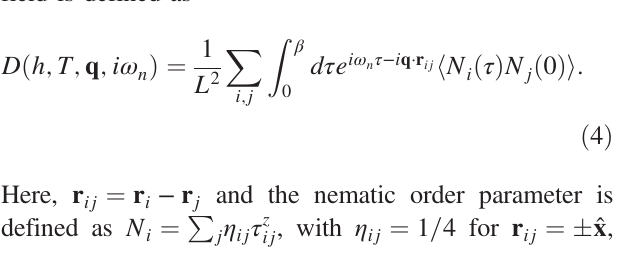
FIG. 5. Nematic susceptibility at the critical h , χ ð h function of temperature. Panel (a) shows the susceptibility on a linear scale. The same data are displayed on a log-log scale in (b). The black line is proportional to 1 =T